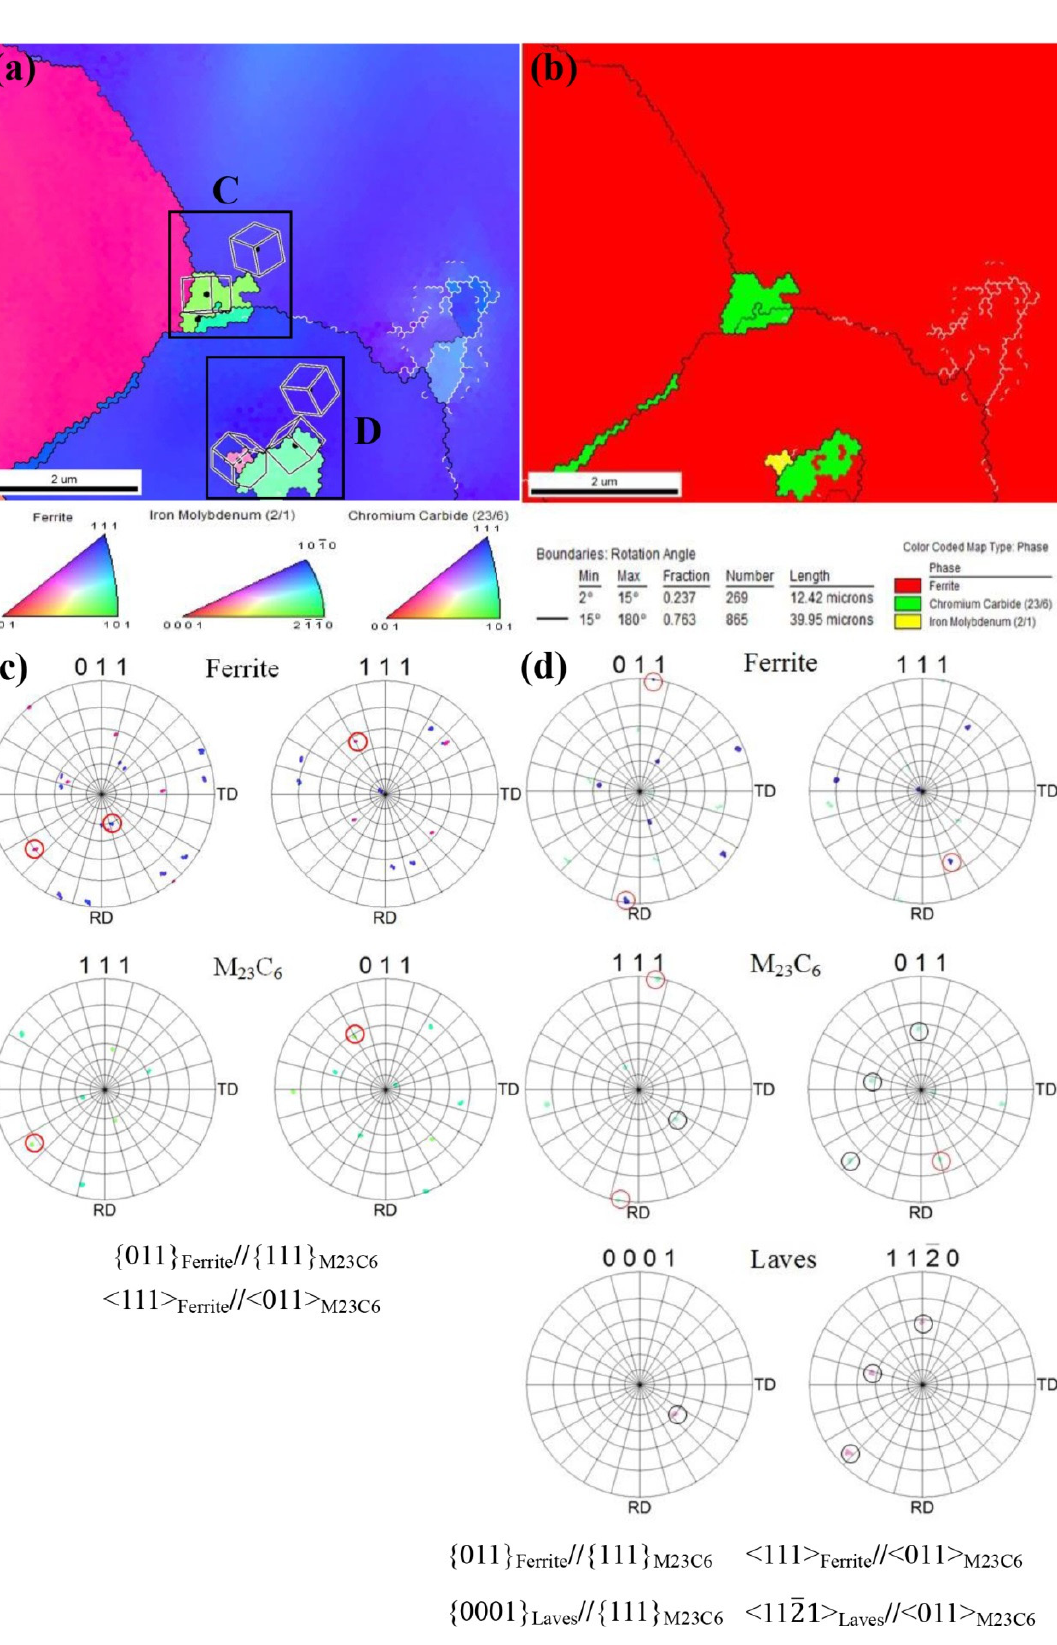
Figure 5. EBSD maps of the P91 steel aged at 625 °C for 5000 h: ( a ) image quality (IQ) and inverse-flame pole figure (IPF), ( b ) Phase distribution, ( c ) Pole Figure (PF) of M23C6 and Ferrite in region C cropped from ( a ), ( d ) PF of M23C6, Laves phase and Ferrite in region D cropped from ( a ).